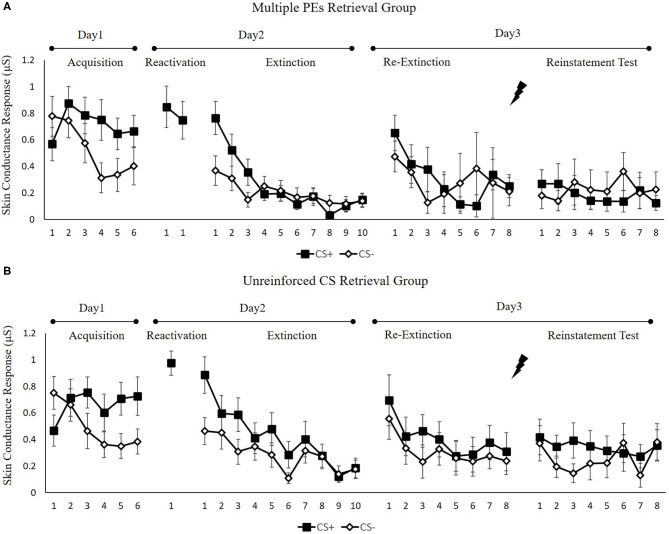
Mean skin conductance responses to the CS+ and CS– trials during acquisition, memory reactivation, extinction, re-extinction, and reinstatement test for (A) the multiple PE retrieval group (n = 17) and (B) the unreinforced CS retrieval group (n = 17). Error bars represent SEM.